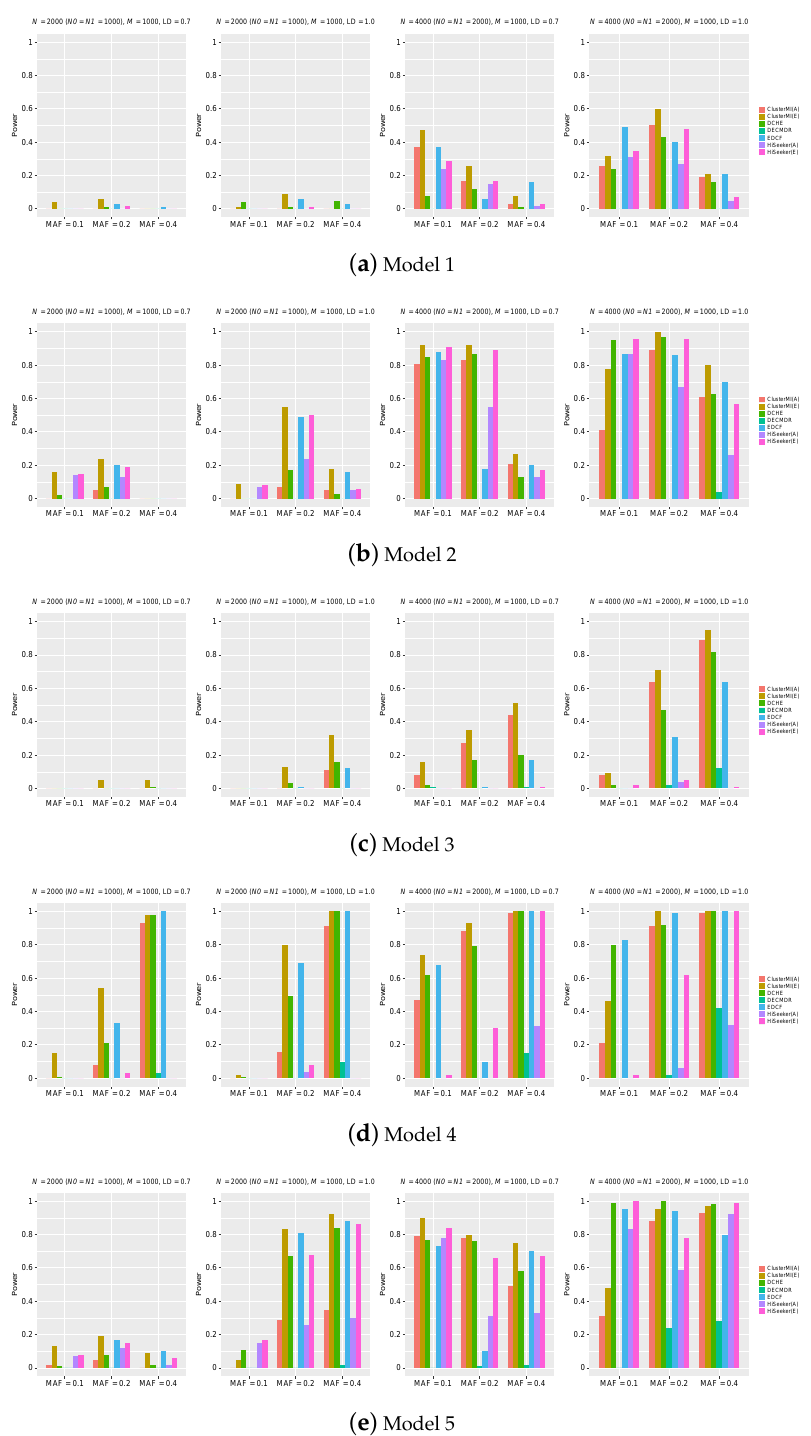
Figure 3. Powers of dynamic clustering for high-order genome-wide epistatic interactions detecting (DCHE), differential evolution algorithm combined with a classification based multifactor- dimensionality reduction (DECMDR), epistasis detector based on the clustering of relatively frequent items (EDCF), HiSeeker(A), HiSeeker(E), ClusterMI(A) and ClusterMI(E) on five three-locus disease models under different allele frequencies (MAF), sample sizes ( N ) and linkage disequilibrium (LD). N 0 is the number of controls, N 1 the number of cases and M the number of SNPs. The absence of a bar indicates no power. A: ACO search strategy, E: exhaustive search strategy. ( a ) Model 1; ( b ) Model 2; ( c ) Model 3; ( d ) Model 4; ( e ) Model